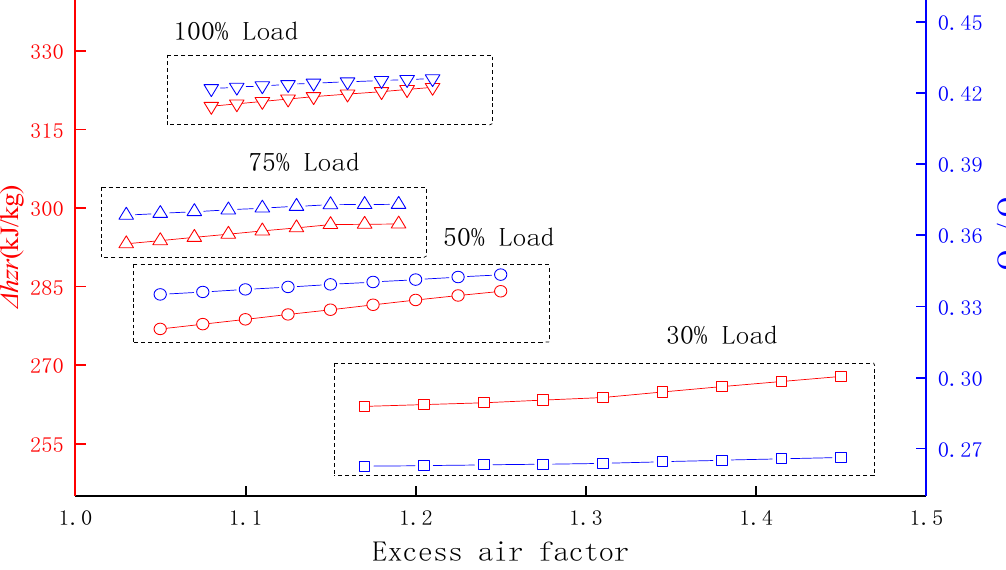
Figure 11. Influence of excess air factor on Δ h zr and Q zr / Q s under different loads.